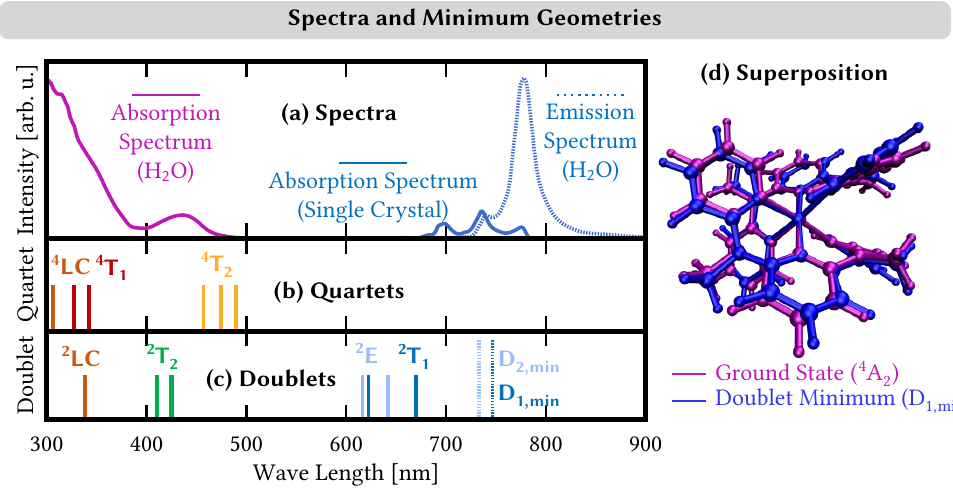
Figure 3. ( a ) Experimental absorption spectra [15] of [Cr(ddpd) ] 3+ in water and in single-crystal 2 form as well as emission spectrum of [Cr(ddpd) ] 3+ in water. Intensities scaled arbitrarily. ( b / c ) Stick 2 spectrum of quartet/doublet states computed using CASPT2 in water. Dashed lines corresponds to the energy of LVC-optimized doublet minimum (D ) and the second-excited doublet state at 1,min this geometry (D ). ( d ) Superposition of geometries of the ground state ( 4 A ) and the lowest 2,min 2 doublet-state minimum (D 1,min